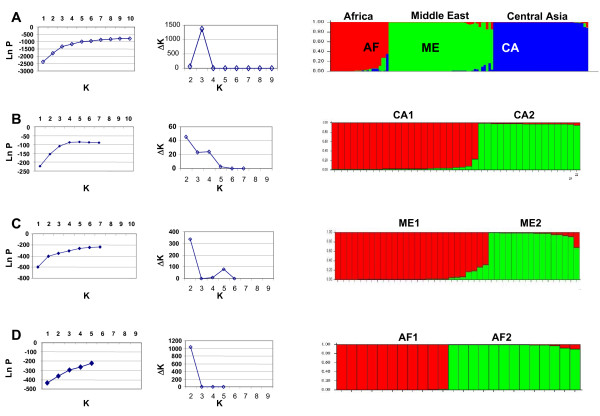
Estimated population structure obtained with STRUCTURE. This is shown as plots of the estimated membership coefficient (Q), which is represented by a single vertical line for each sample. Coloured segments represent the sample's estimated membership in each of the K inferred clusters. Individual isolates can have membership in multiple clusters, with membership coefficients summing up to 1 across clusters. Panel A represents the STRUCTURE result for the whole data set, whereas panels B – D show sub-structuring obtained when STRUCTURE was re-run for each main population separately. CA = Central Asia; ME = Middle East; AF = Africa.